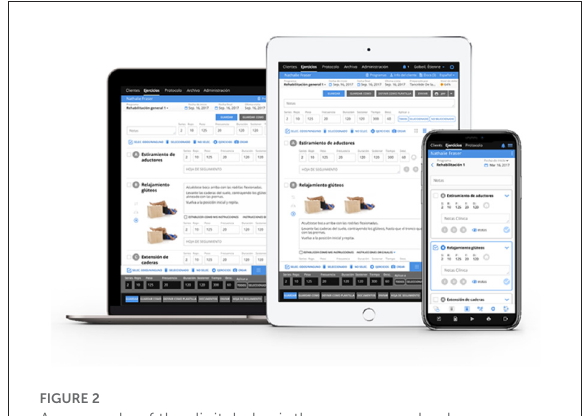
FIGURE2 An example of the digital physiotherapy app and a demo programme.